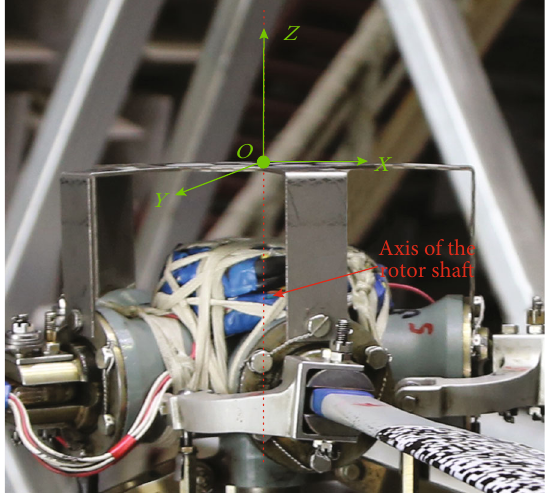
Figure 13: Rotor coordinate